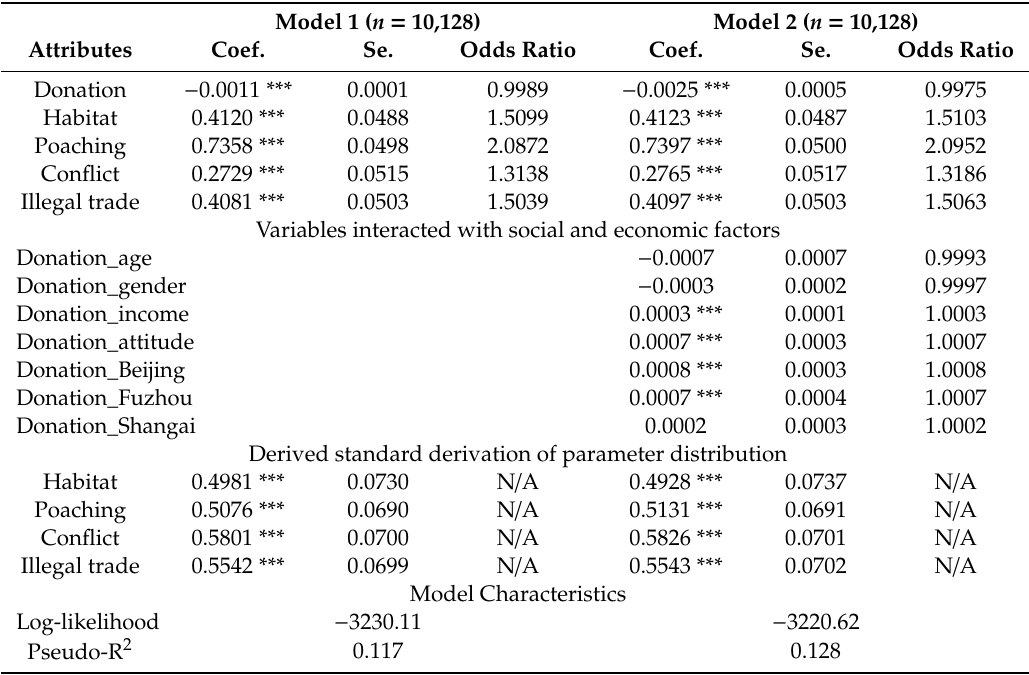
Table 4. Results from the mixed logit regression